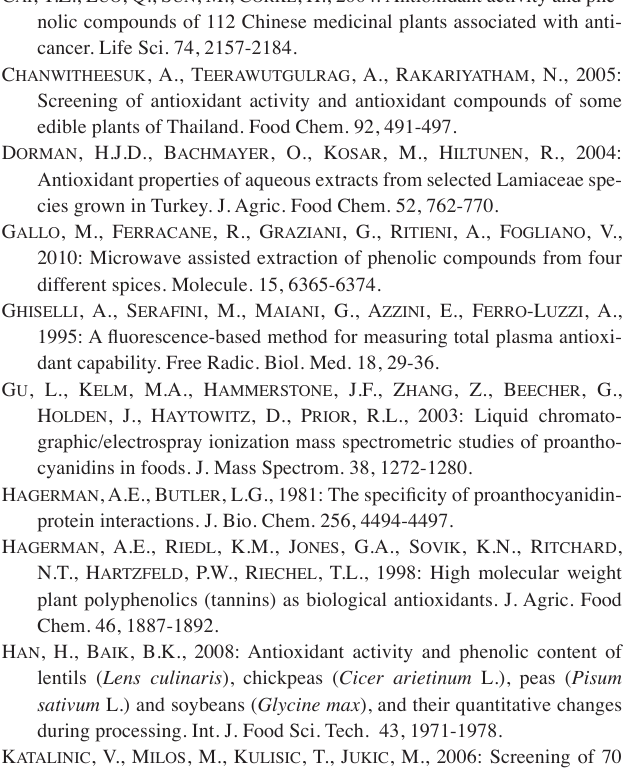
compounds contribute significantly to the total antioxidant capacity of medicinal plants. The lack of correlation between TRAP assay and TPC is probably due to the before mentioned low sensitivity of this assay to high polymerised phenolic